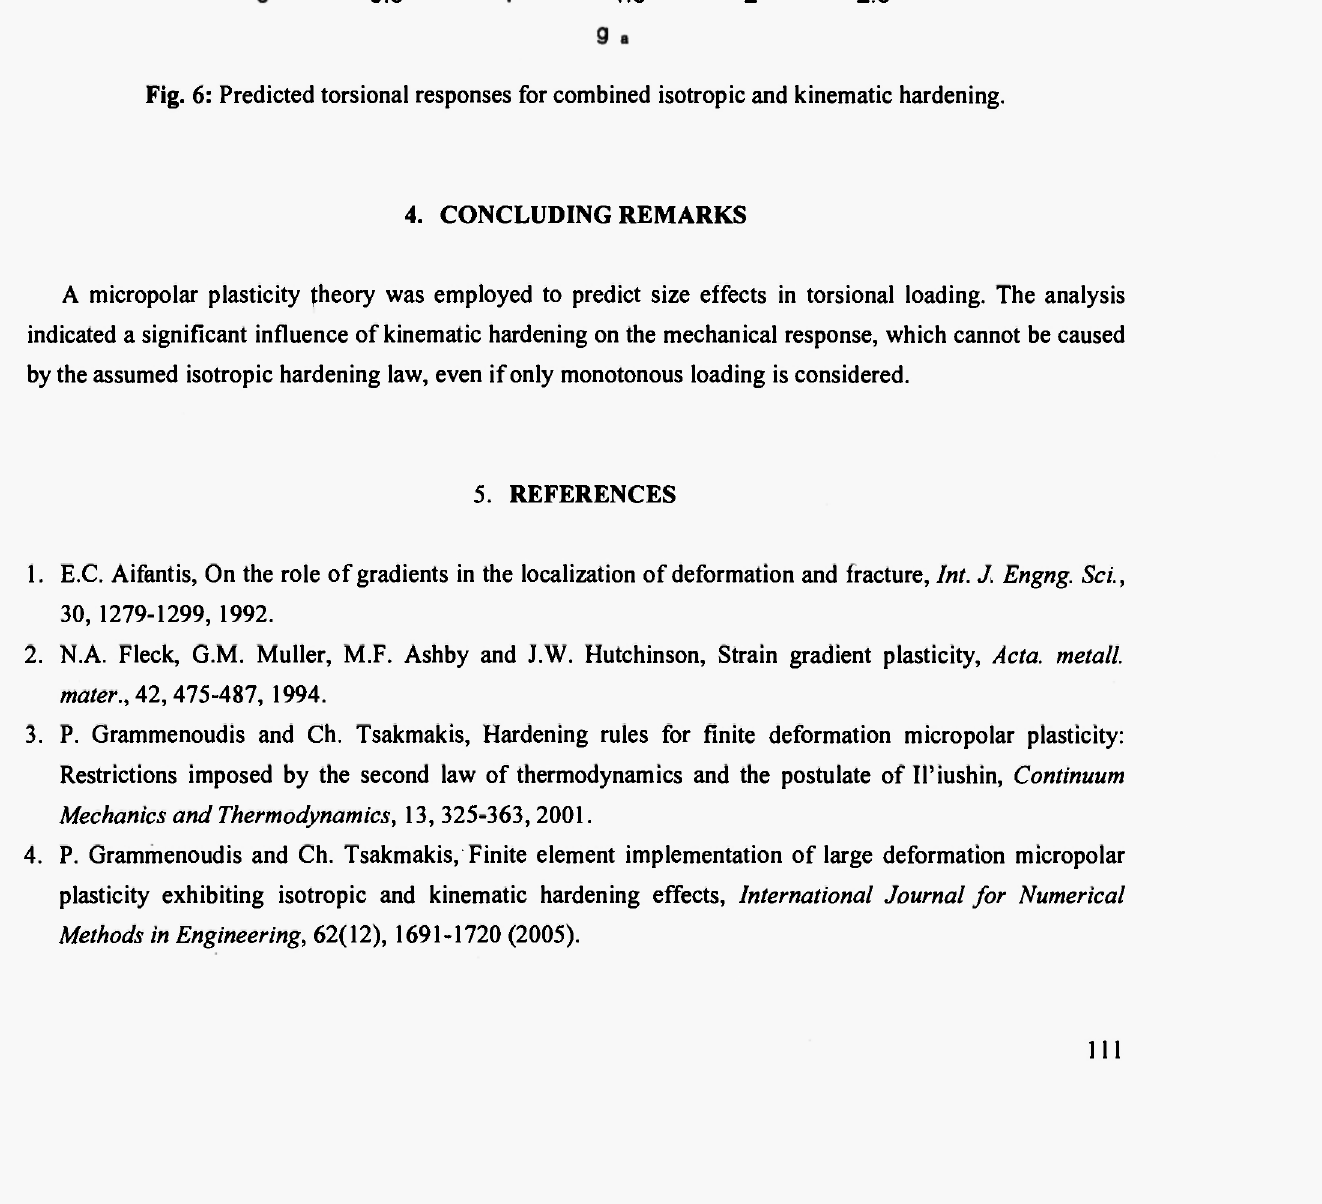
Fig. 6: Predicted torsional responses for combined isotropic and kinematic